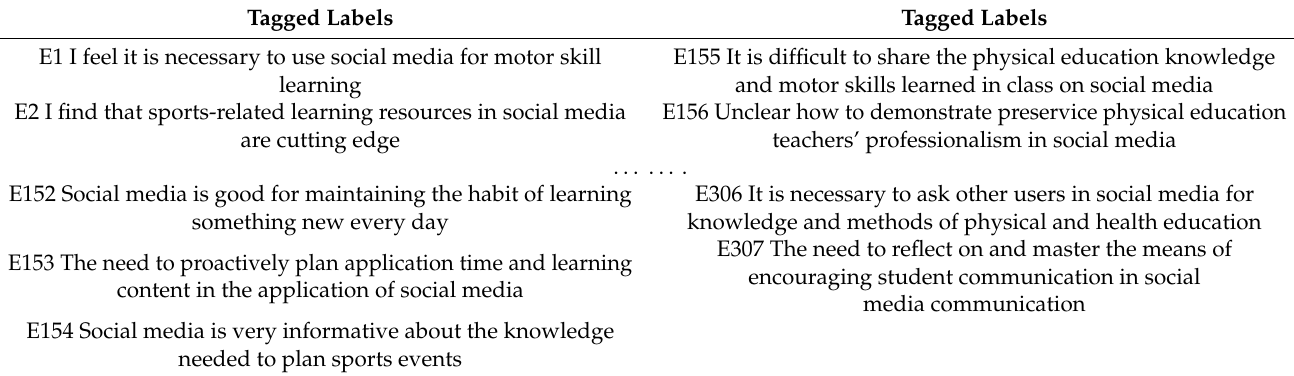
Table 3. Labeling results.